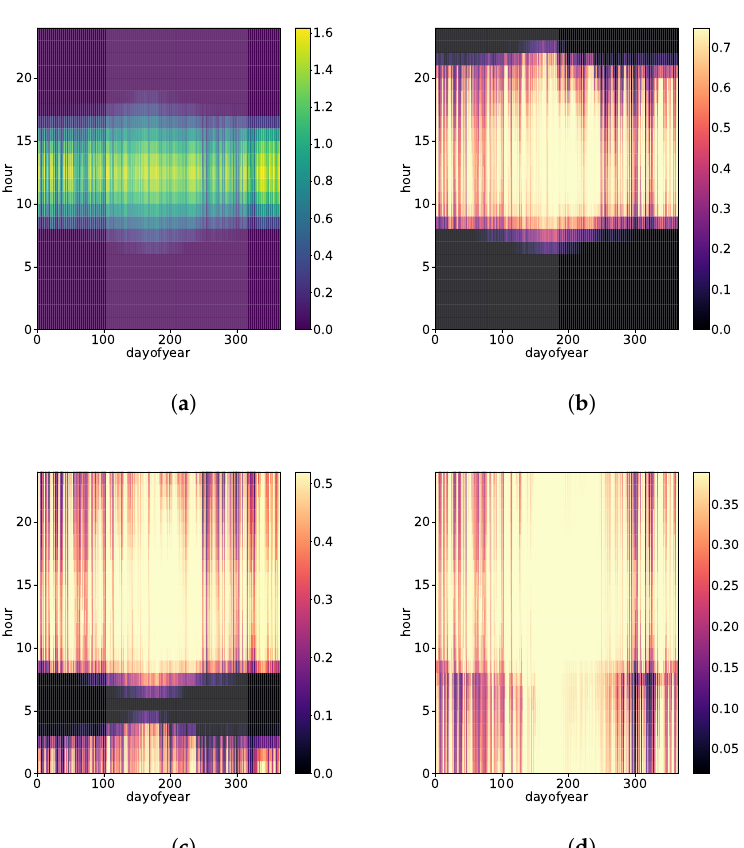
Figure 8. Heatmap of the national daily (ordinate) and seasonal (abscissa) variability of the predicted capacity factors of CSP without storage (SM1) ( a ), CSP-TES SM2 ( b ), CSP-TES SM3 ( c ), CSP-TES SM4 ( d ). SM > 1: with increasing levels of storage. The variation over time is shown in colour by intensity in the colour